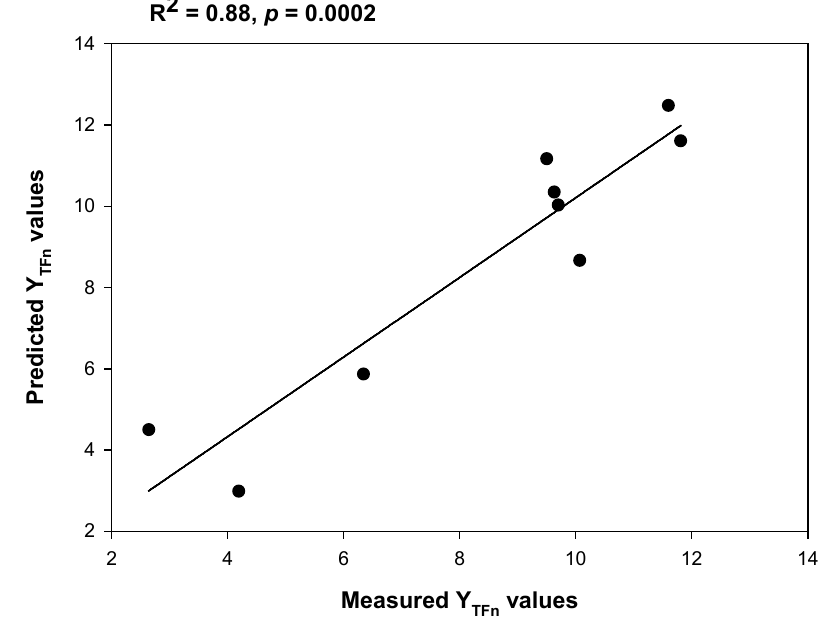
Figure 3. Correlation between the observed Y TFn values and those predicted by the established kinetic model.